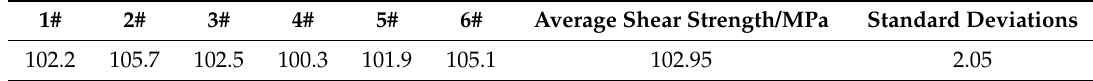
Table 3. The shear strength for the samples brazed with side solder feeding.